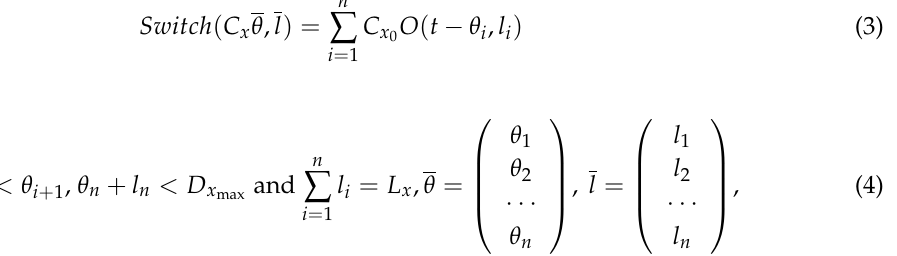
Figure 1. Shifting behavior of the generic load shift model.